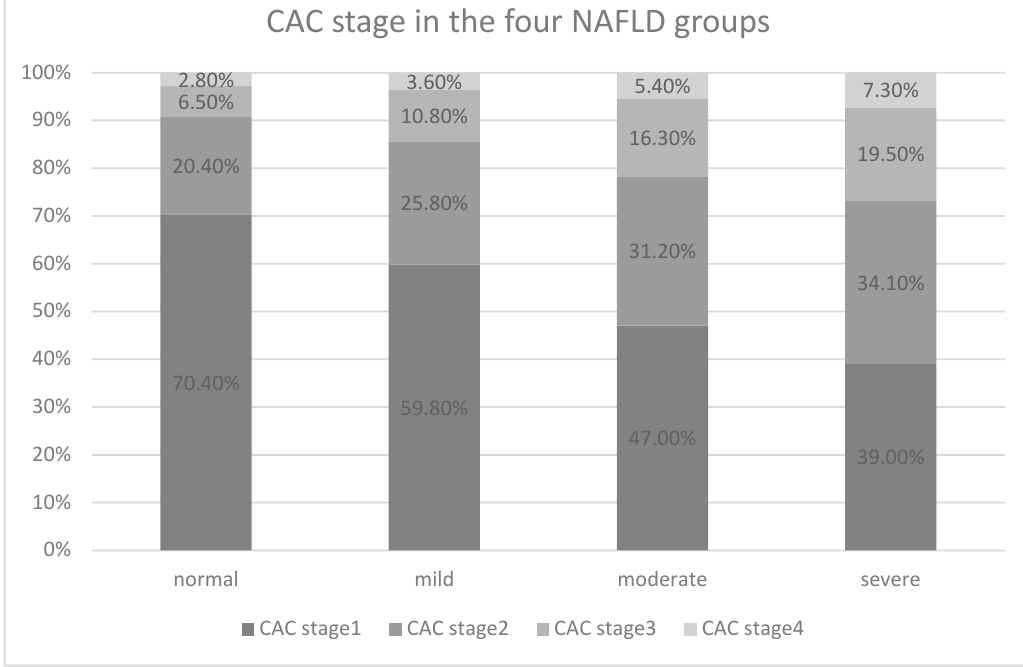
Figure 1. Percentage of CAC stage in different severity of NAFLD.